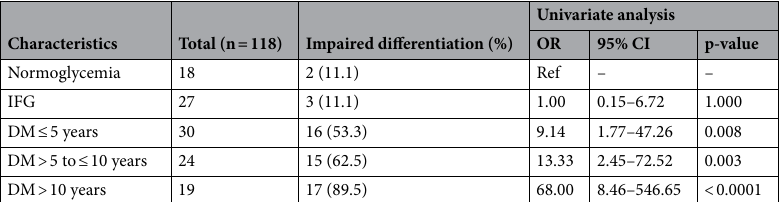
Characteristics Total (n = 118) Impaired differentiation